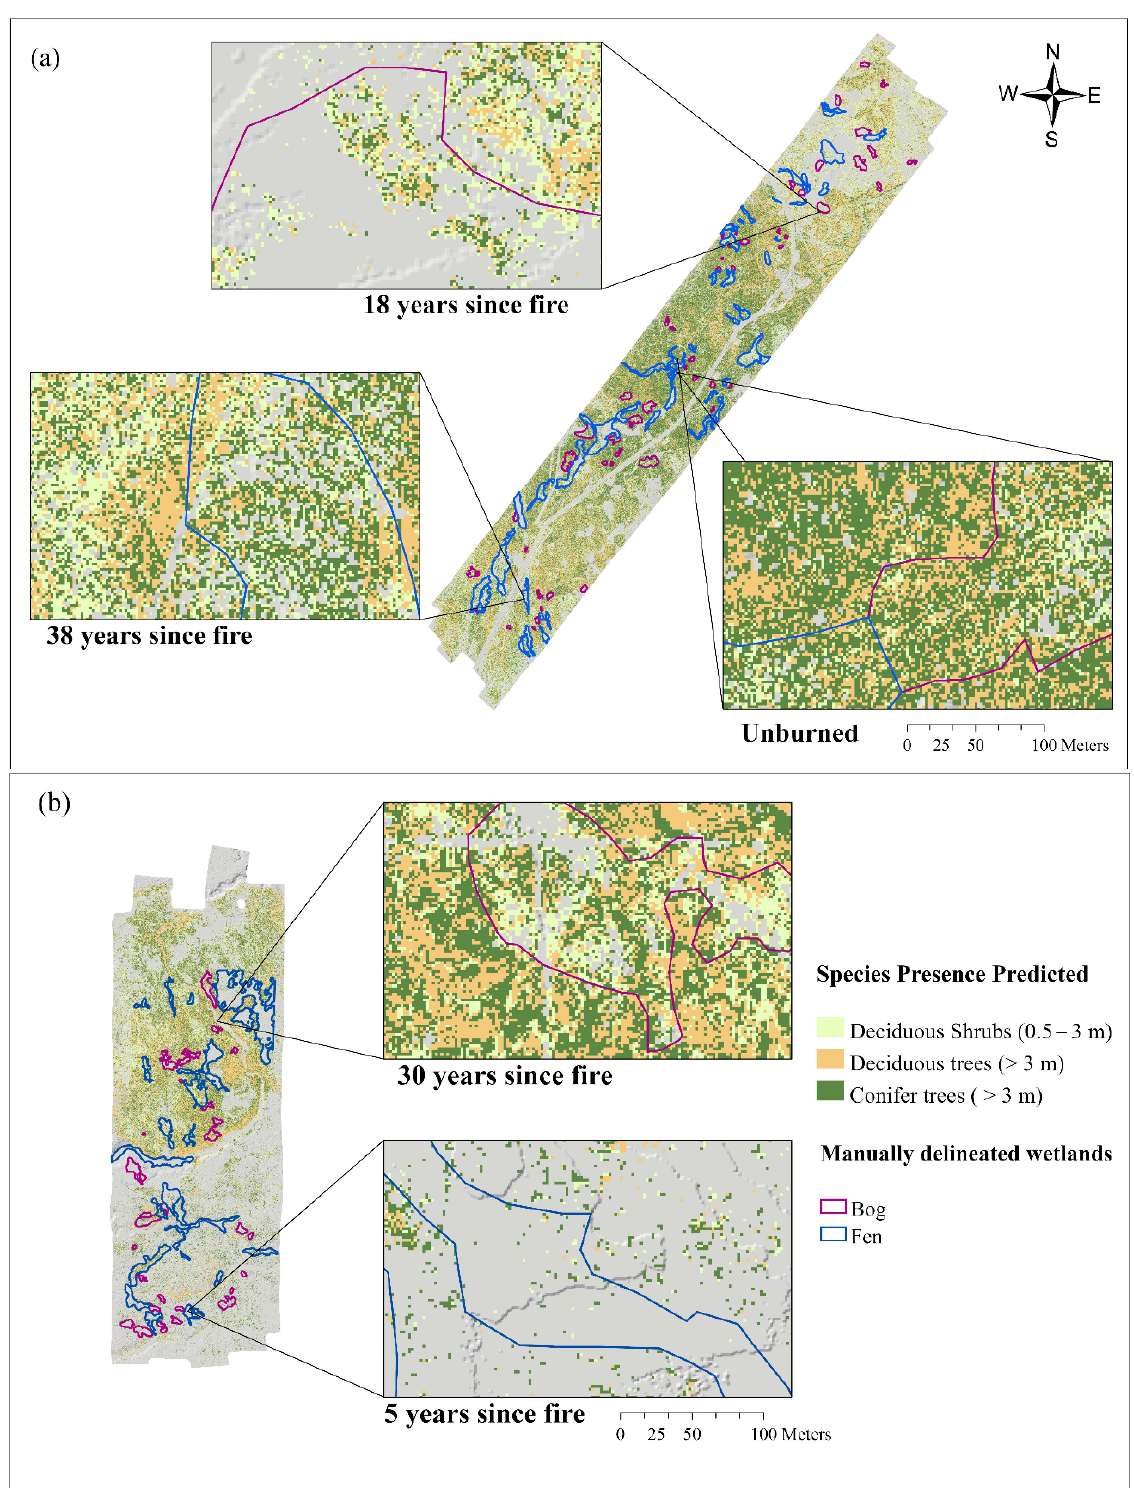
Figure 6. Prediction raster generated for ( a ) western lidar polygon including vegetation regeneration 18 YSF, 38 YSF, and recently unburned peatlands and ( b ) eastern lidar polygon including vegetation regeneration 5 YSF and 30 YSF. No data areas shaded in grey represent vegetation height less than 0.5 m. These low vegetation areas are typically representing ground cover, Labrador tea, and herbaceous species.